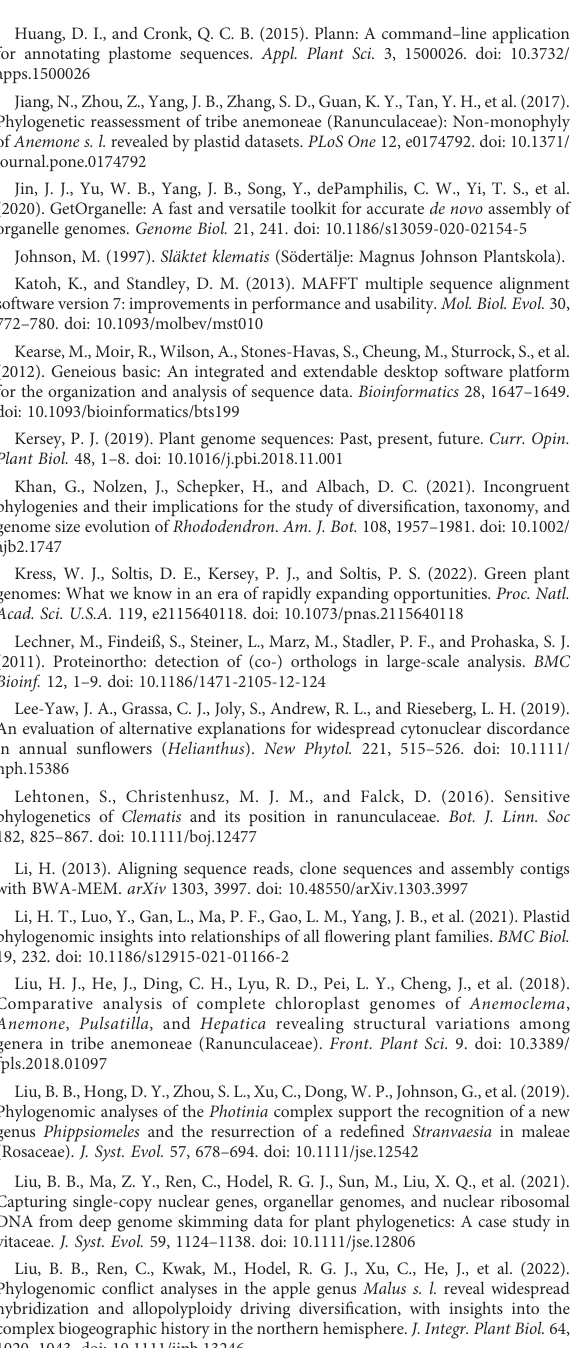
SUPPLEMENTARY FIGURE 3 Maximum likelihood phylogenetic trees constructed from three nuclear SNPs data matrices obtained by GATK pipeline.